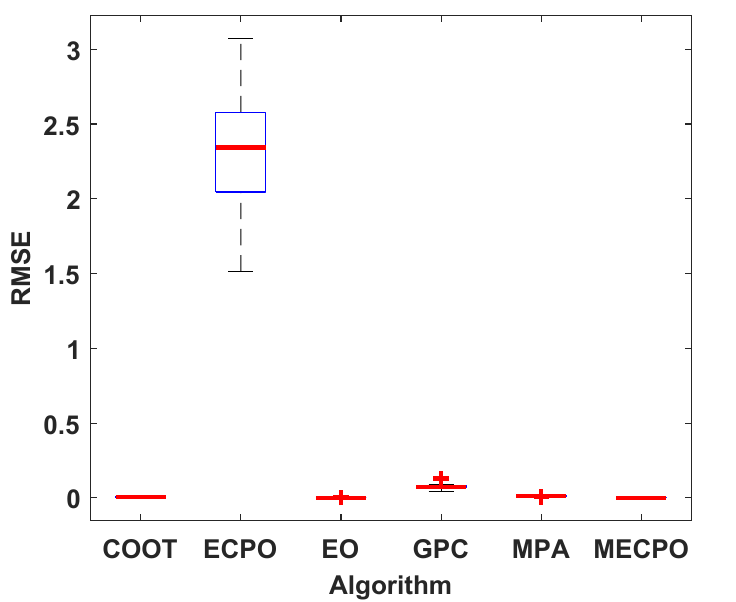
Figure 13. Best RMSE boxplot in 20 individual runs of the MECPO and other recent algorithms for the DDM.